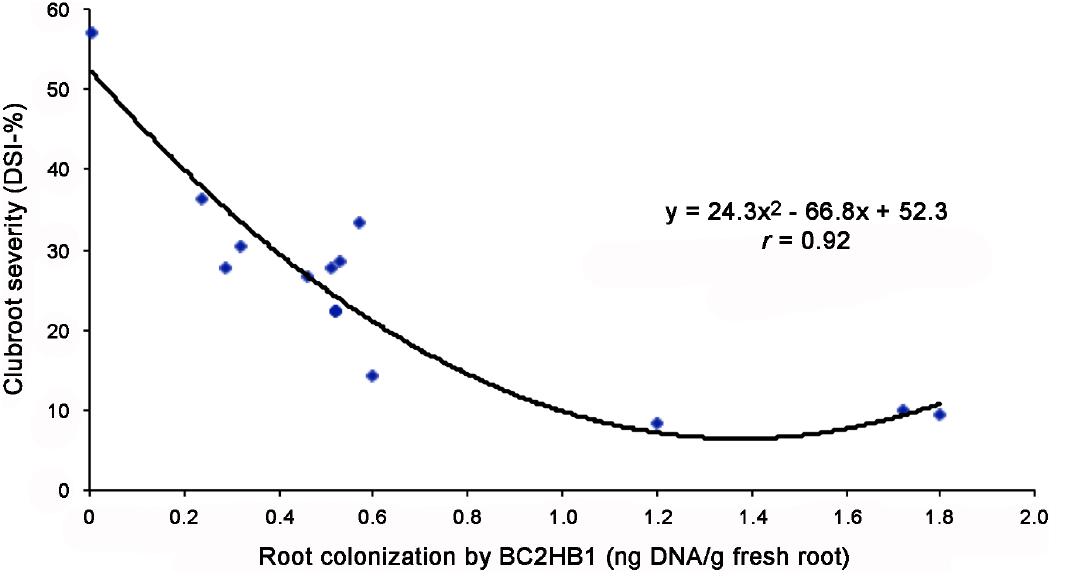
Figure 3. The relationship between colonization of canola roots by BC2HB1 (ng DNA/g of fresh root) at 14 days after seeding and clubroot severity (DSI) at 5 weeks after seeding. The plants were inoculated with Plasmodiophora brassicae at 2 6 10 5 spores pot 2 1 (low inoculum dose).